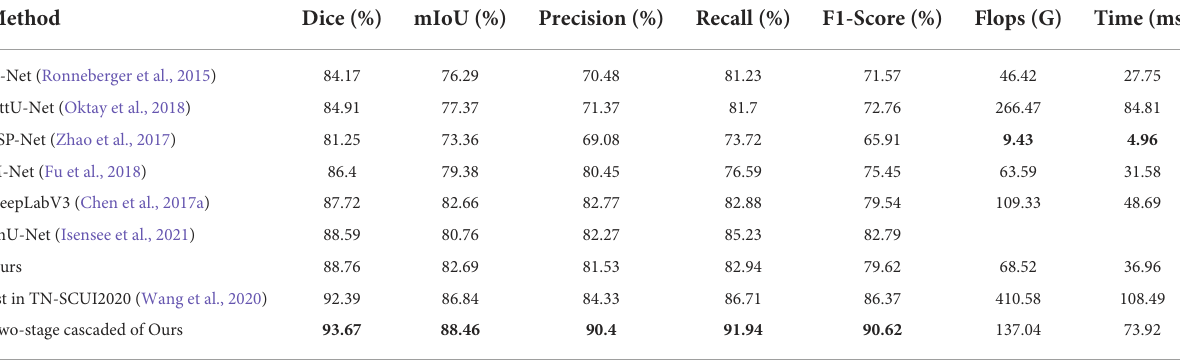
TABLE 2 Thyroid nodule segmentation performance of different segmentation approaches on the DDTI dataset. Method